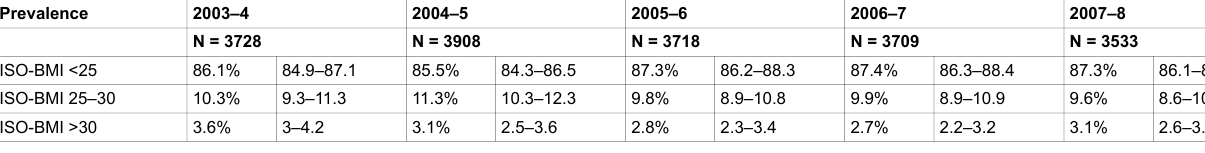
Table 1 Distribution of the prevalence (95% confidence intervals) divided into ISO-BMI subgroups for the entire group. Prevalence